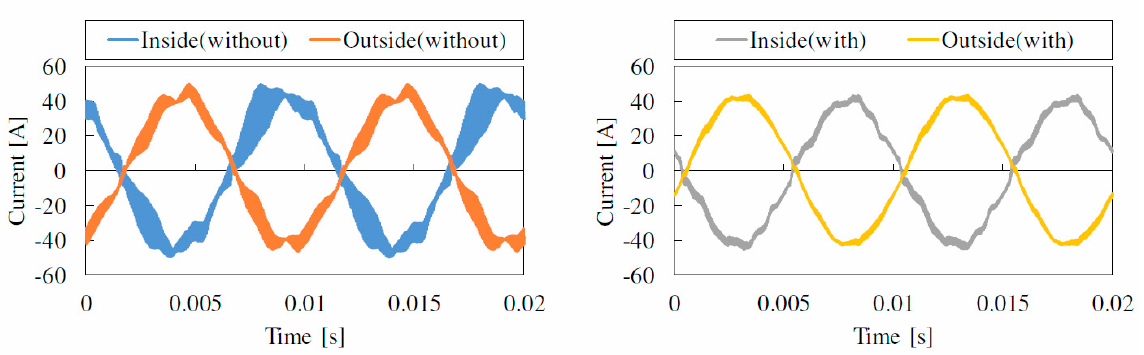
Figure 22. Measured current waveforms with/without PWM carrier shift control. ( Left ) shows it without control,